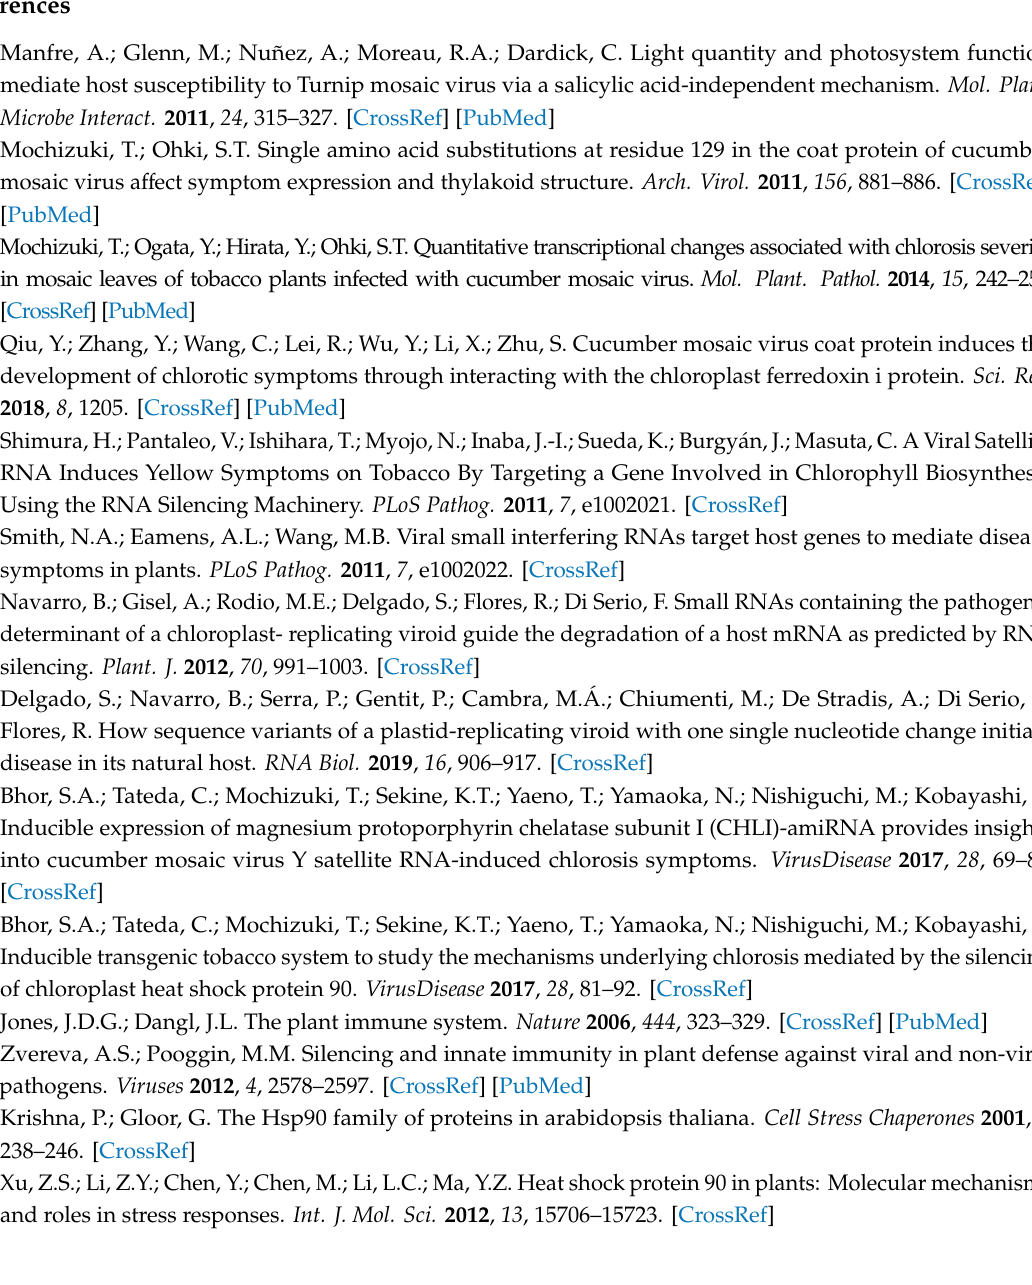
three comparisons). Supplementary Table S5: List of downregulated DEGs in chlorosis model plants (commonly downregulated DEGs in all three comparisons). Supplementary Table S6: List of GO terms (biological process) enriched with upregulated DEGs of chlorosis model plants. Supplementary Table S7: List of GO terms (biological process) enriched with downregulated DEGs of chlorosis model plants. Supplementary Table S8: Expression levels of RS-related transcription factor